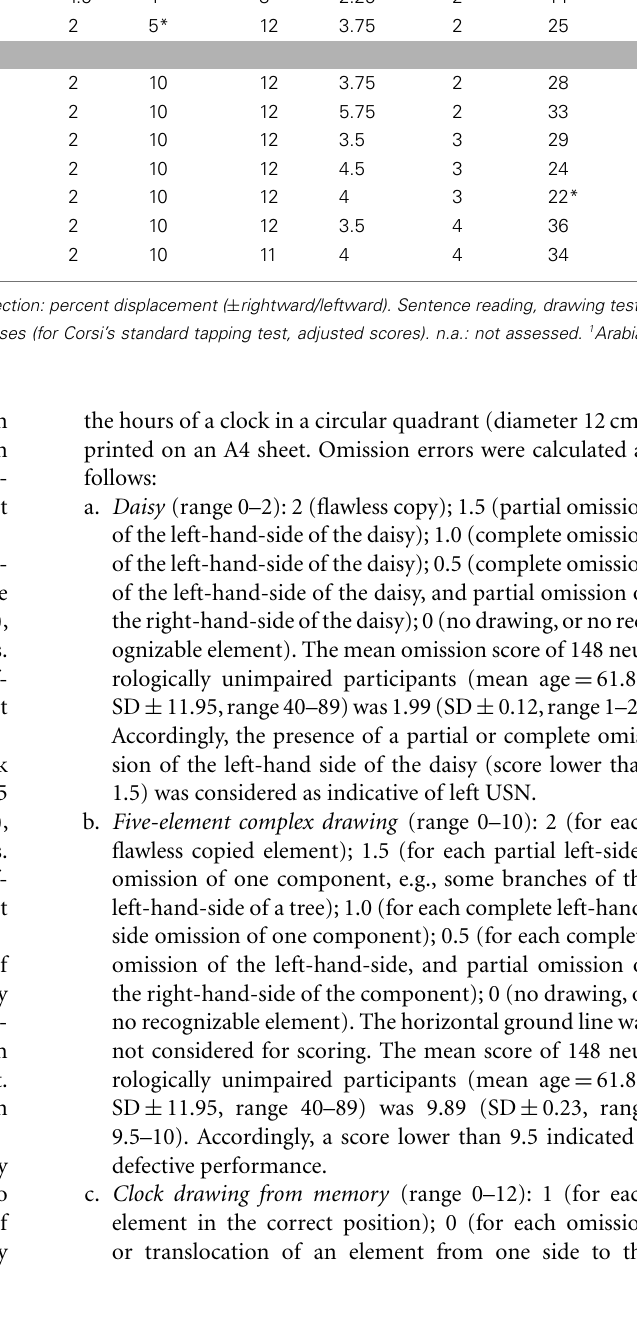
Tactile tapping test